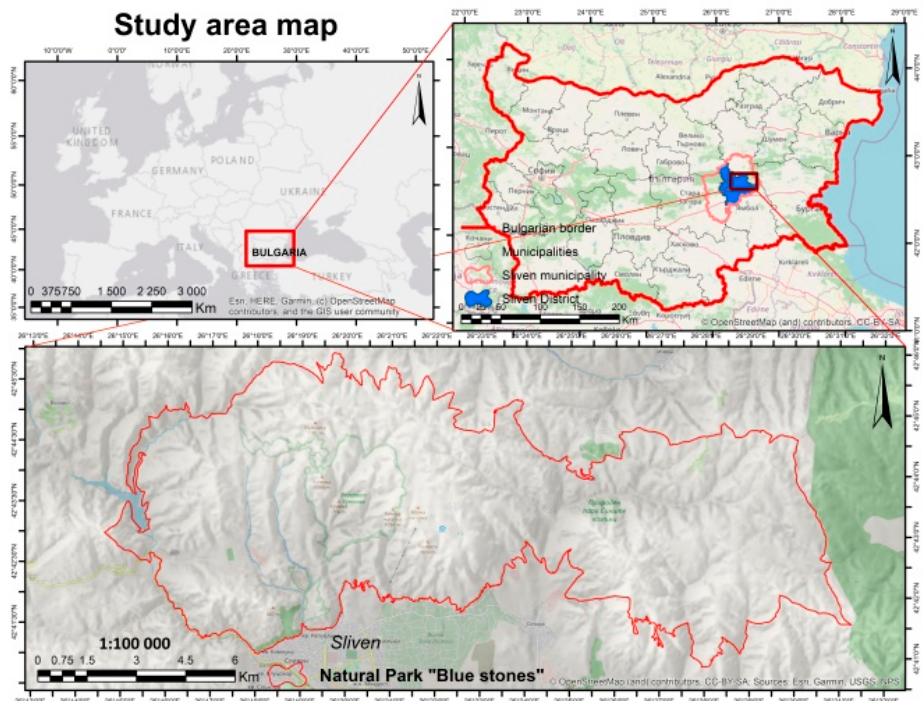
Figure 1. Study area map.